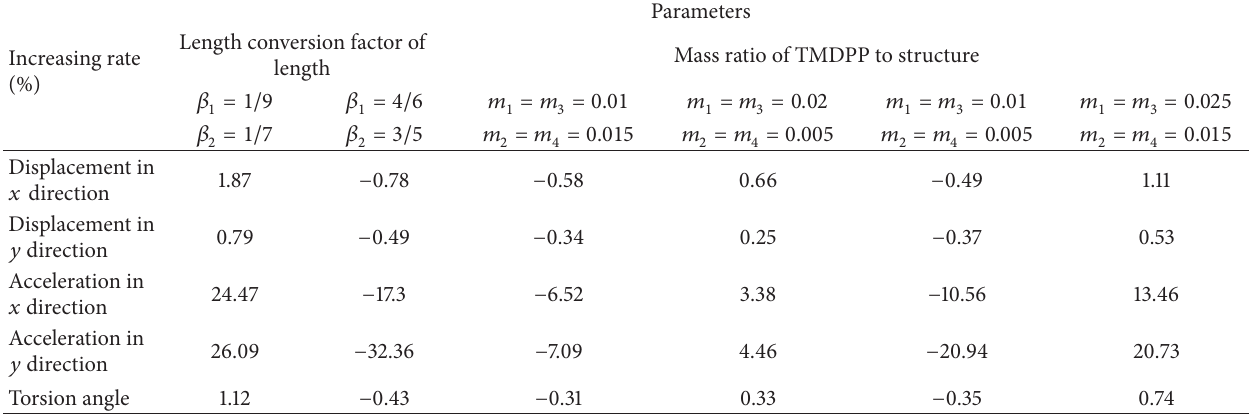
Table 4: Increasing rate of damping ratio of the TMDPPs with different design parameters.